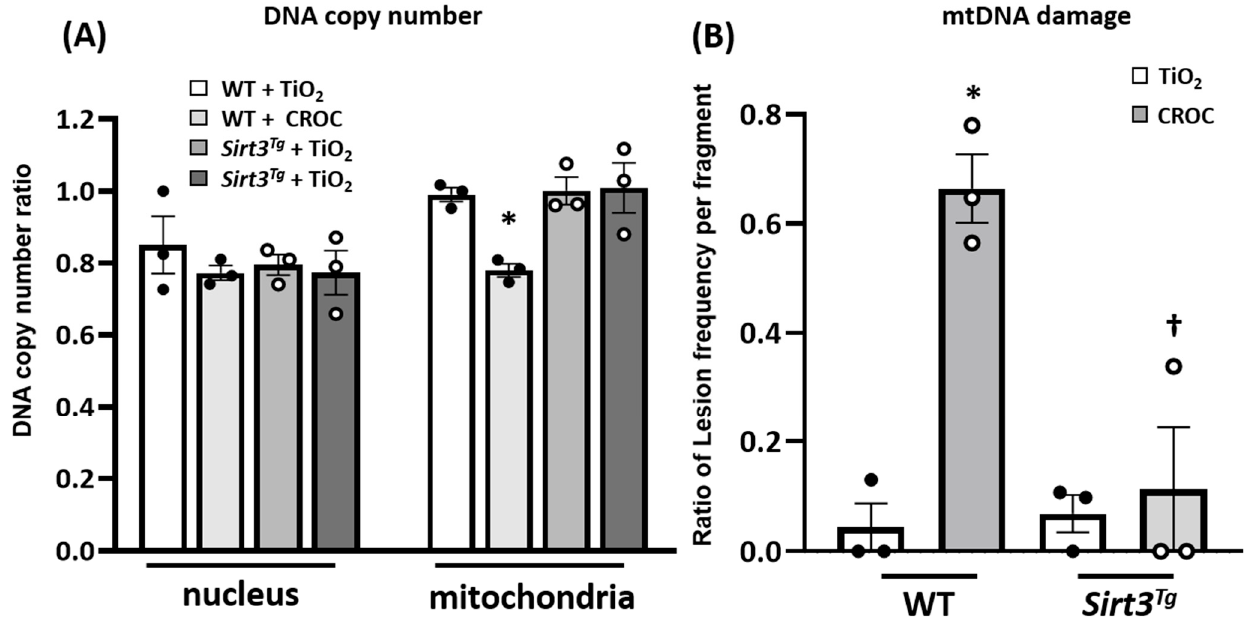
Figure 2. Sirt3 Tg mice exhibit reduced asbestos-induced lung mtDNA damage as compared to WT. Lung tissues from mice in Figure 1 were assessed by a q-PCR assay for lung nuclear and mtDNA copy number ( A ) and lung mtDNA damage ( B ). N = 3; * p < 0.05 vs. WT + Ti. † p < 0.05 vs. WT + CROC.